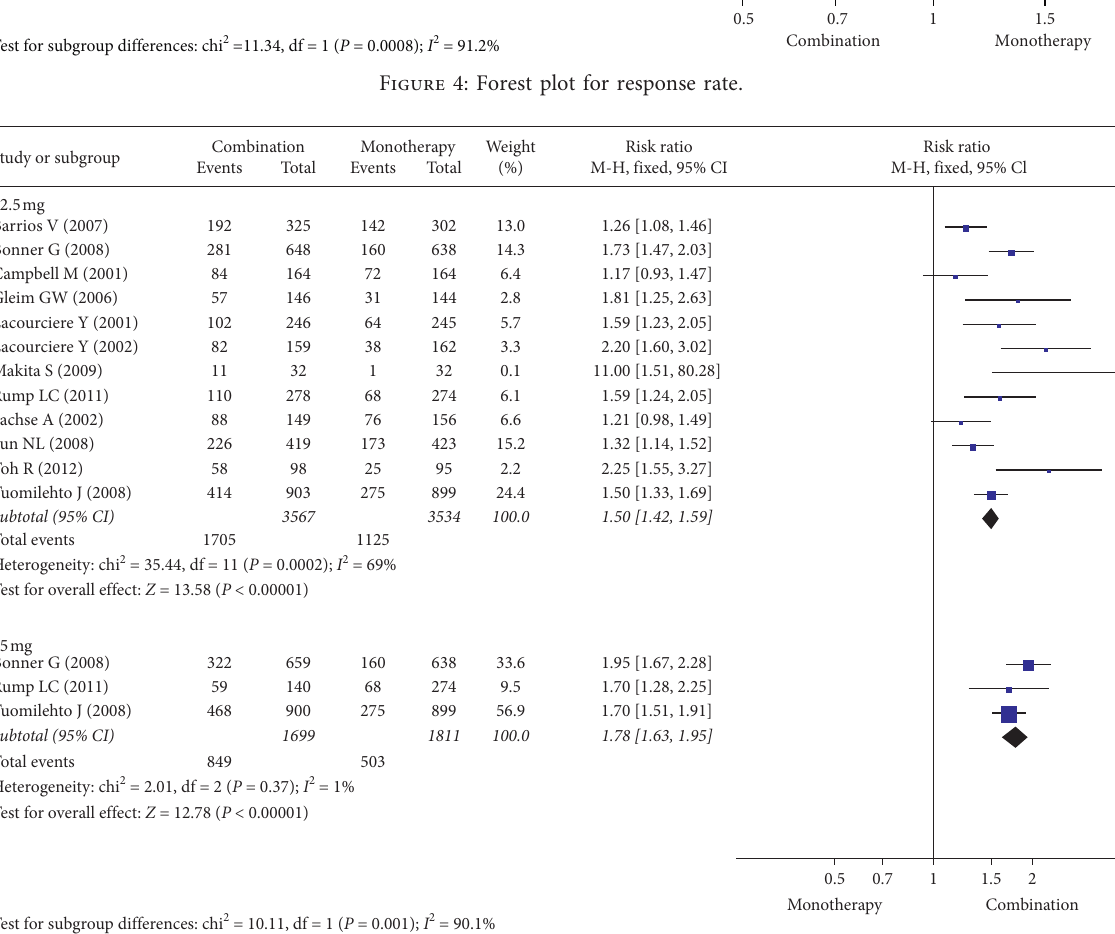
Monotherapy Test for subgroup differences: chi 2 =11.34, df = 1 ( P = 0.0008); I 2 = 91.2%